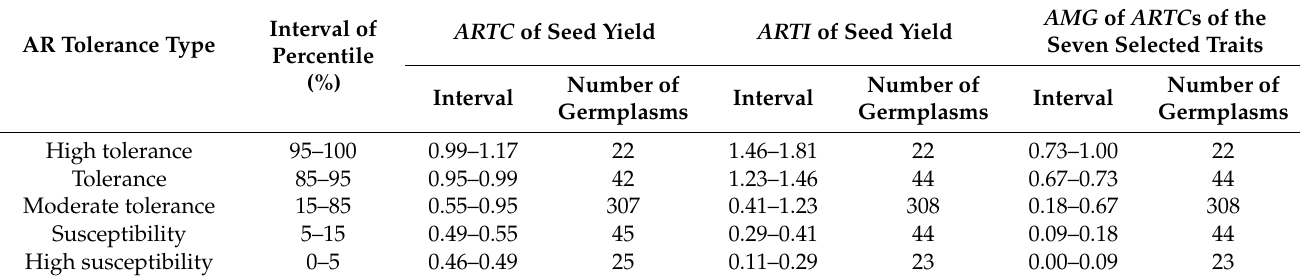
Table 5. Grouping intervals and frequency distributions of AR tolerance grades using ARTC of seed yield, ARTI of seed yield, and AMG of ARTC s of the seven selected traits as evaluation criteria for the tested soybean population.